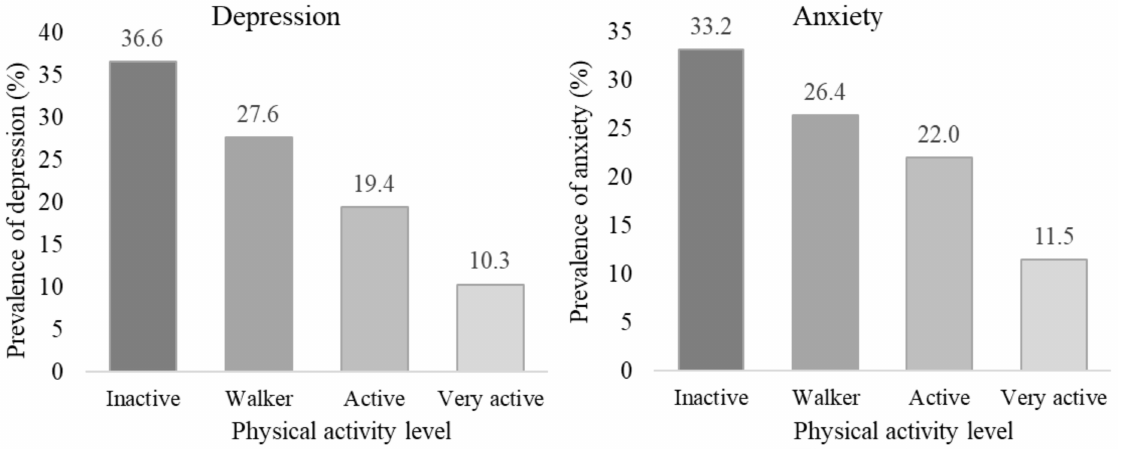
Figure 2. Prevalence of depression and anxiety, according to physical activity level. As shown in Figure 3, the prevalence of negative SPH decreased from 31.1% in the inactive population to 5.1% in the very active population, and differences in